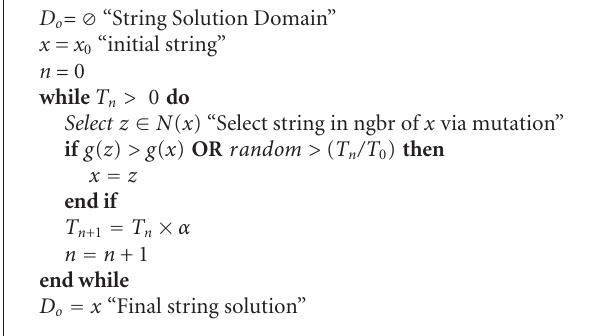
Algorithm 1: SA RTSPP Initial Specification.